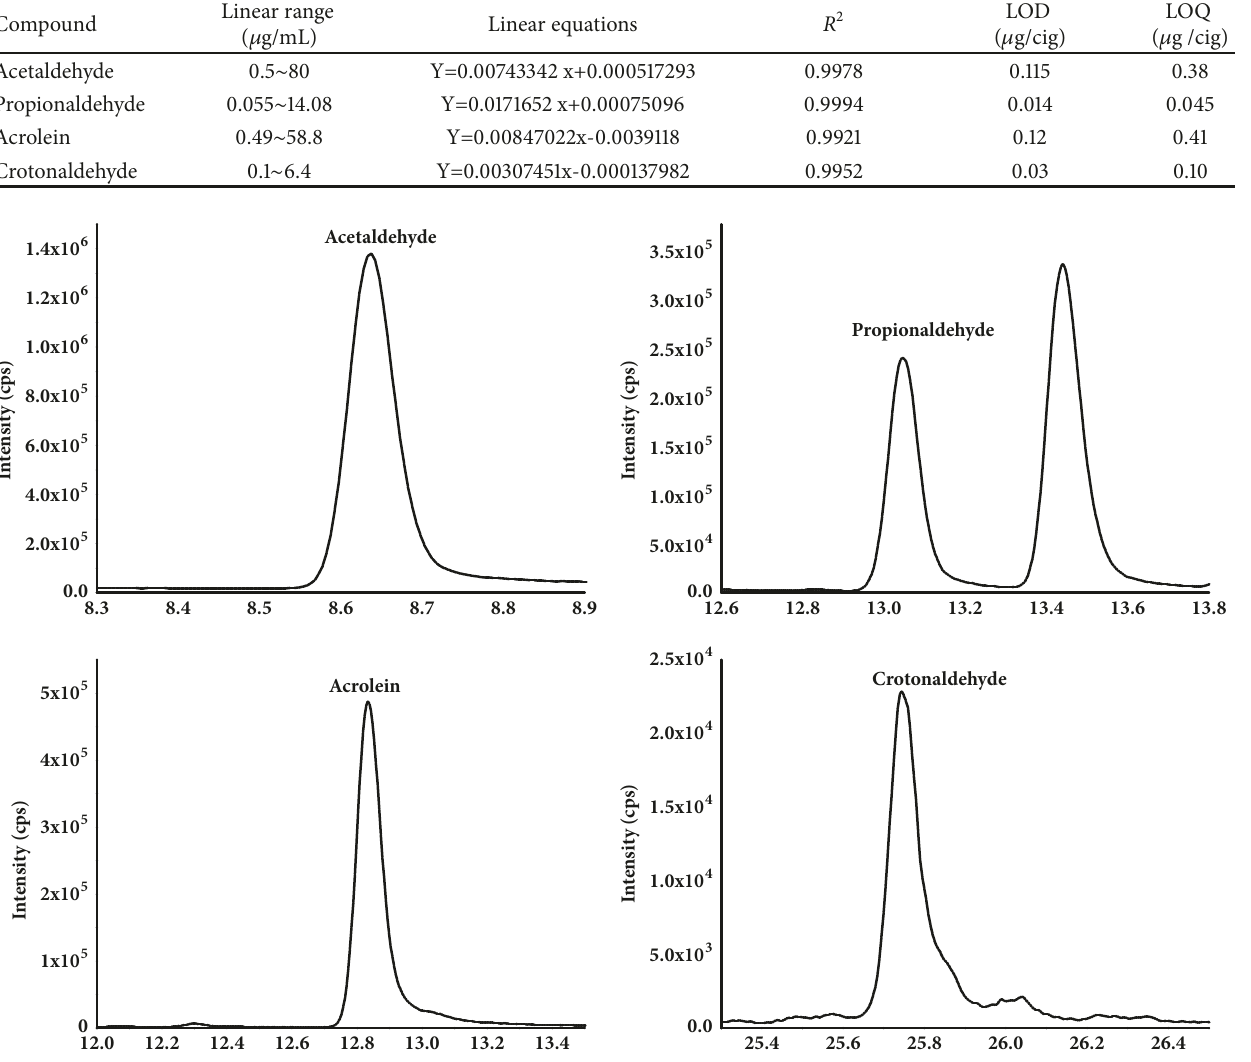
Table 3: Linear equations, LODs, and LOQs of acetaldehyde, propionaldehyde, acrolein, and crotonaldehyde ( n =6).